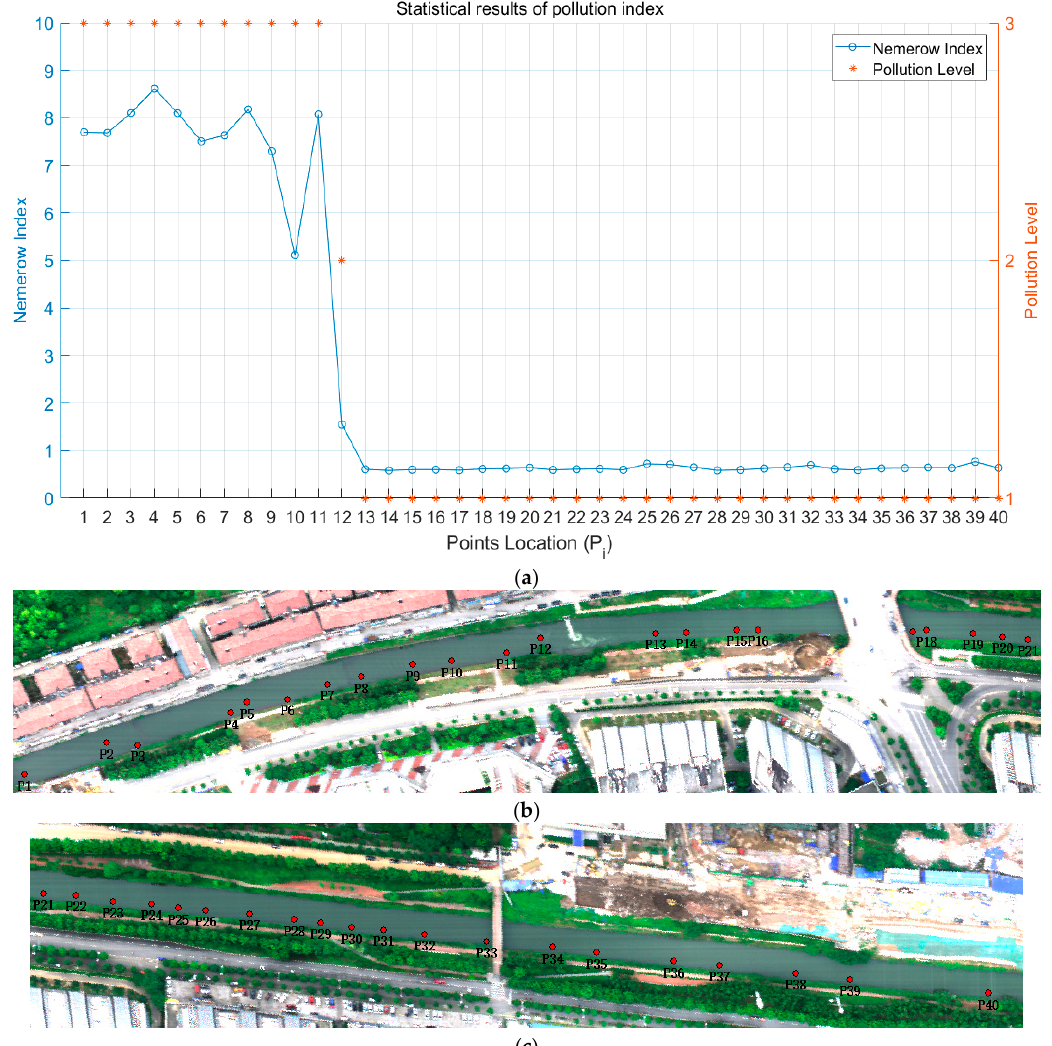
Figure 8. Statistical results of the pollution level and the Nemerow index for the Shahu Port dataset. ( a ) line chart; ( b ) spatial distribution of sampling points upstream; ( c ) spatial distribution of sampling points downstream.